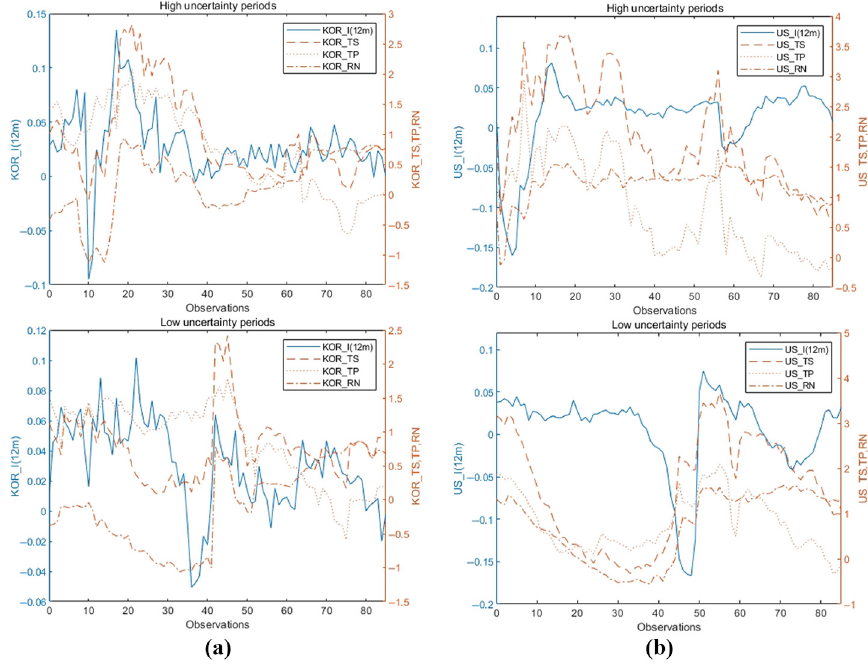
Figure 2. Time-series of